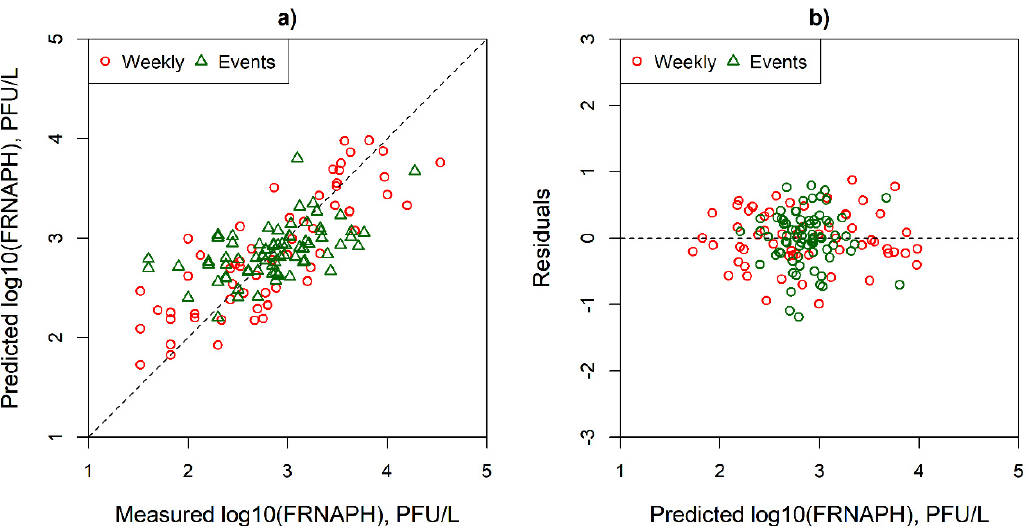
Figure 6. ( a ) Scatter plot between the measured and predicted log-transformed FRNAPH concentrations, and ( b ) the residuals versus predicted log-transformed FRNAPH concentrations from the hydrological and meteorological variables for the weekly and event datasets.